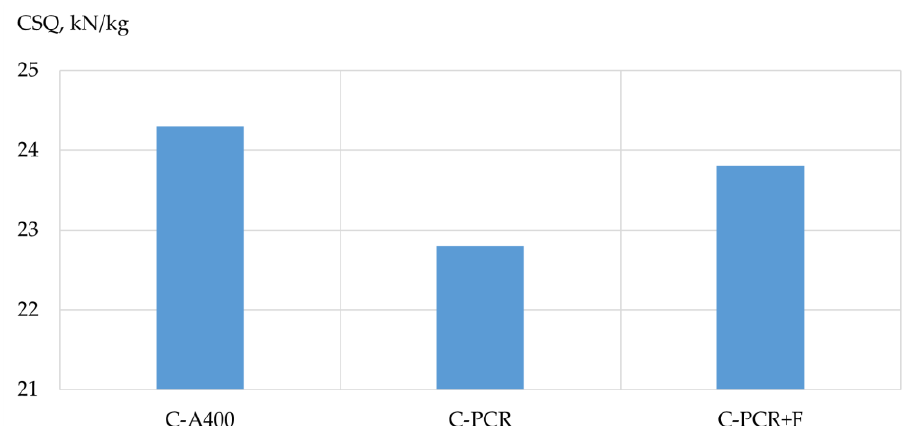
Figure 8. Dependence of the structural quality factor of the sample columns on the type of reinforce- ment used: C-A400 is a sample column reinforced with steel reinforcement of class A400; C-PCR is a sample-column reinforced with polymer composite reinforcement; C-PCR+F is a sample-column reinforced with polymer composite reinforcement and glass fiber.